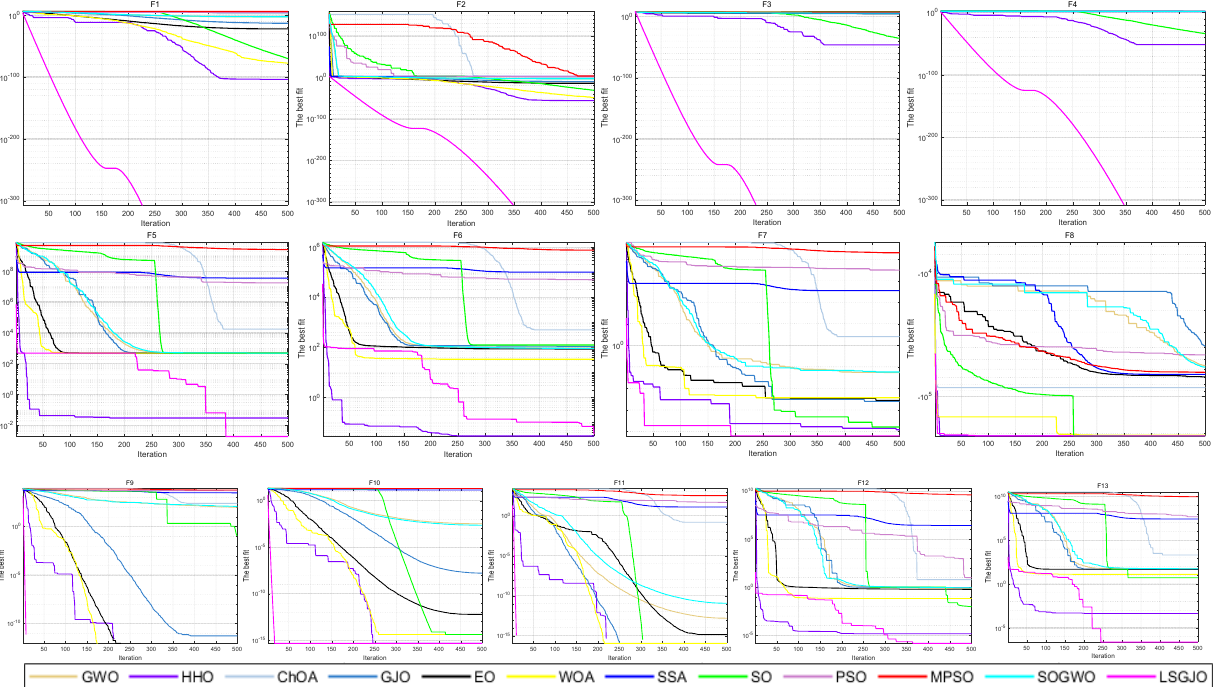
Figure 6. The convergence curves of the LSGJO and other comparison algorithms with Dim ═ 500. Table 4. Results and comparison of different algorithms on 13 benchmark functions with Dim ═ 100. The best results of the experiments are shown in bold.